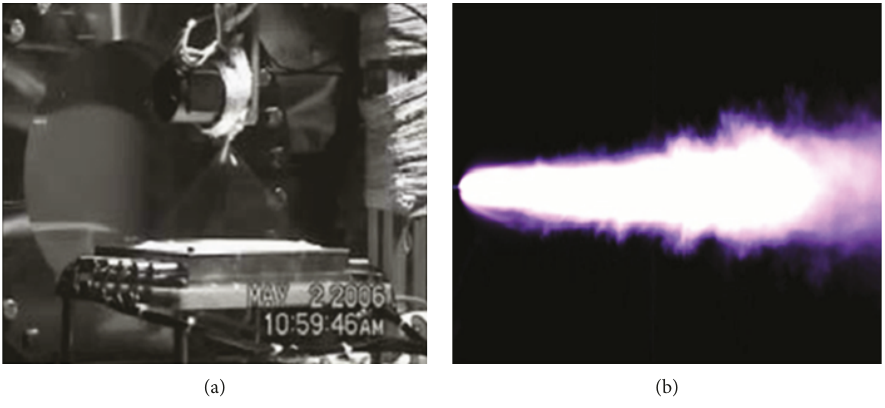
Figure 1: (a) Physical images of fl ash evaporation spray cooling [18]. (b) Physical images of jet fl ash evaporation